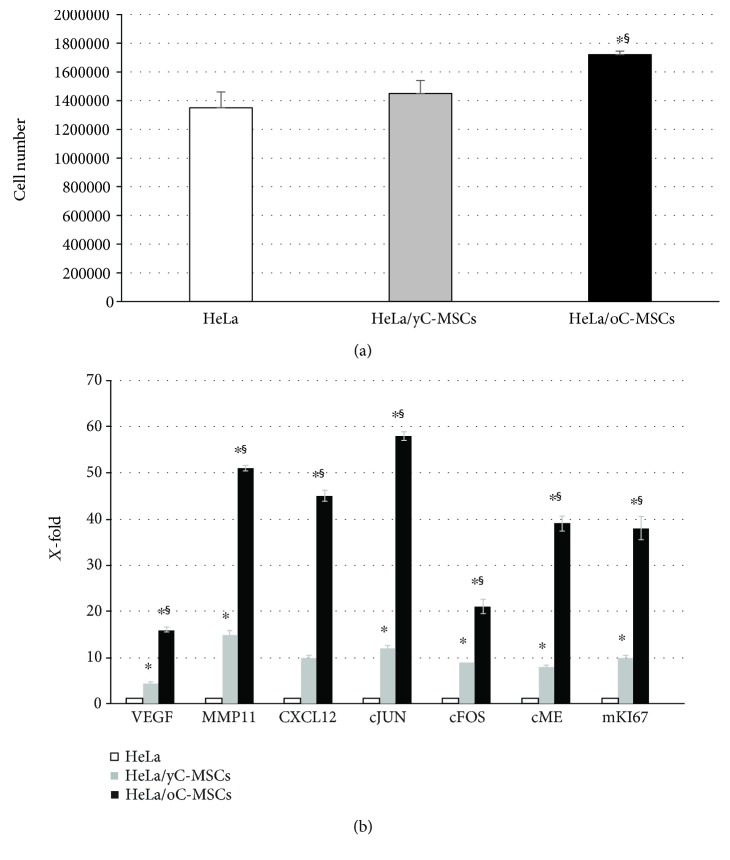
Proliferation and expression of genes related to tumorigenesis in HeLa cells after indirect coculture with MSCs. HeLa cells were indirectly cocultured for 72 hours with yC-MSCs (HeLa/yC-MSCs) or oC-MSCs (HeLa/oC-MSCs). HeLa cultured alone were used as control. (a) Proliferation was assessed by an automated cell counter; ∗p < 0.05 for HeLa/yC-MSCs or HeLa/oC-MSCs versus HeLa and §p < 0.05 for HeLa/yC-MSCs versus HeLa/oC-MSCs. (b) The histogram displays the expression of selected genes related to specific cellular mechanisms, such as oncogenesis (cFOS, cJUN, and cMET), invasion and migration (MMP11), proliferation (mKI67), and angiogenesis (VEGF, CXCL12) in HeLa cells after cocultures with the yC-MSCs and oC-MSCs. Levels of expression detected in cocultured HeLa are referred to as X-fold with respect to individually cultured HeLa (expressed as 1). ∗p < 0.05 for HeLa/yC-MSCs or HeLa/oC-MSCs versus HeLa and §p < 0.05 for HeLa/yC-MSCs versus HeLa/oC-MSCs.